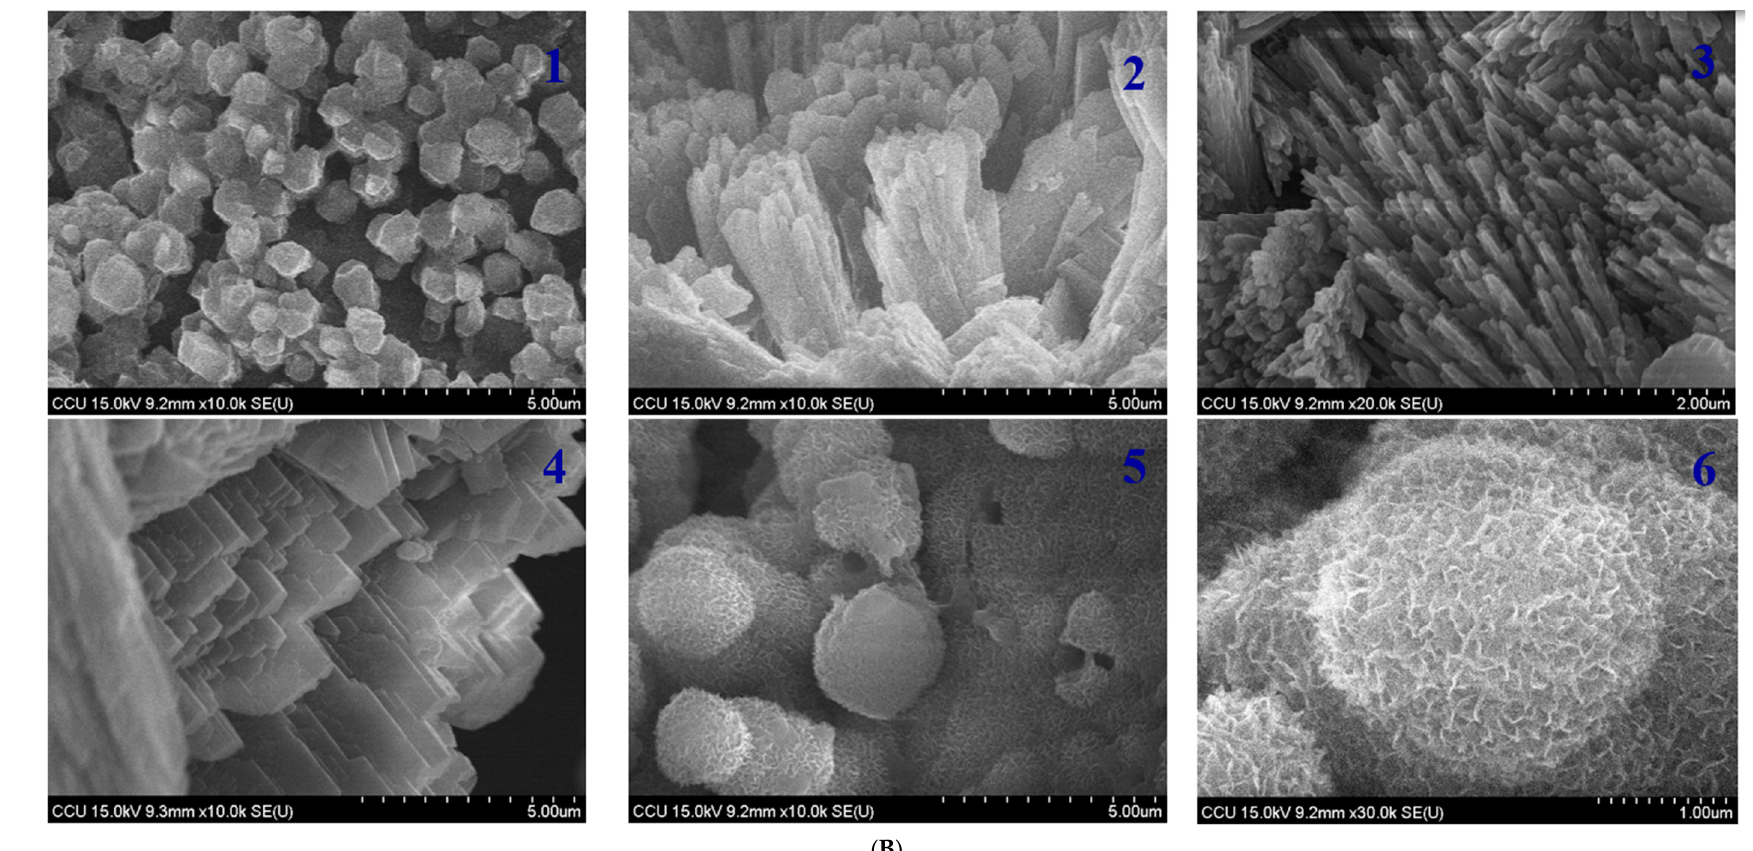
Figure 6. ( A ): SEM imagines of calcium carbonate precipitated by monoculture bacterial experiments. Top row (for upper part of column) showed the trigonal prism CaCO 3 (1 and 2) and rod-shaped calcite (3). Down row (for down part of column) showed the large and compact calcite with the irregular flakes of CaCO 3 (4, 5 and 6). ( B ): SEM imagines of calcium carbonate precipitated by coculture bacterial experiments. Top raw (for down part of column) showed the granular calcite (1) and rod-shaped calcite (2 and 3). Down raw (for upper part of column) showed compact and lamellar calcite (4), and spherulitic vaterite . (5 and 6).